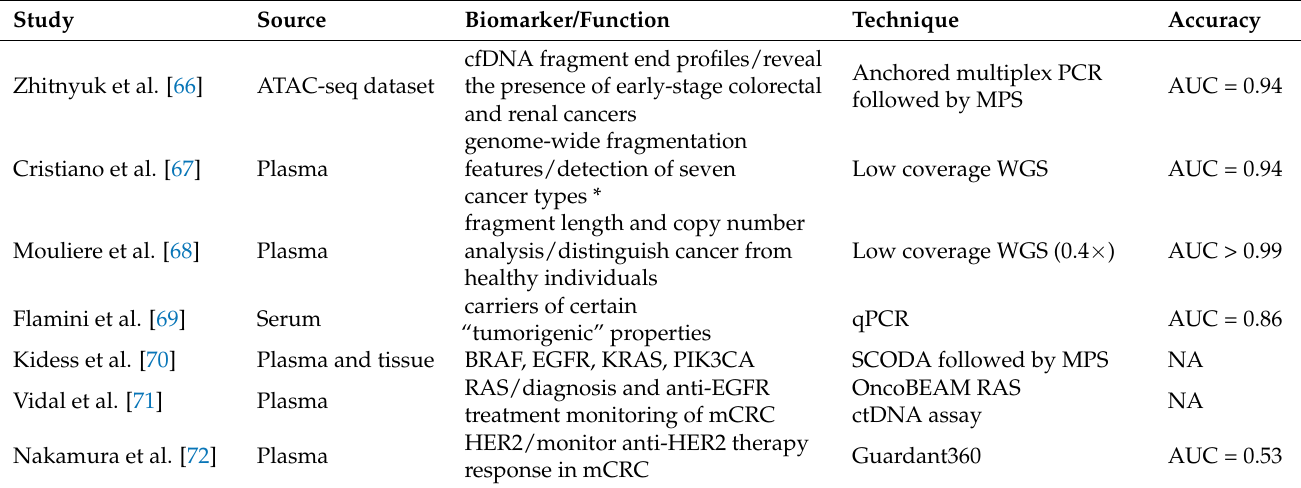
NA—not available; AUC—area under the ROC curve; MPS—massively parallel sequencing; WGS—whole genome Table 2. List of cfDNA/ctDNA biomarkers in mutation analysis and CRC management. sequencing; * breast, colorectal, lung, ovarian, pancreatic, gastric, and bile duct